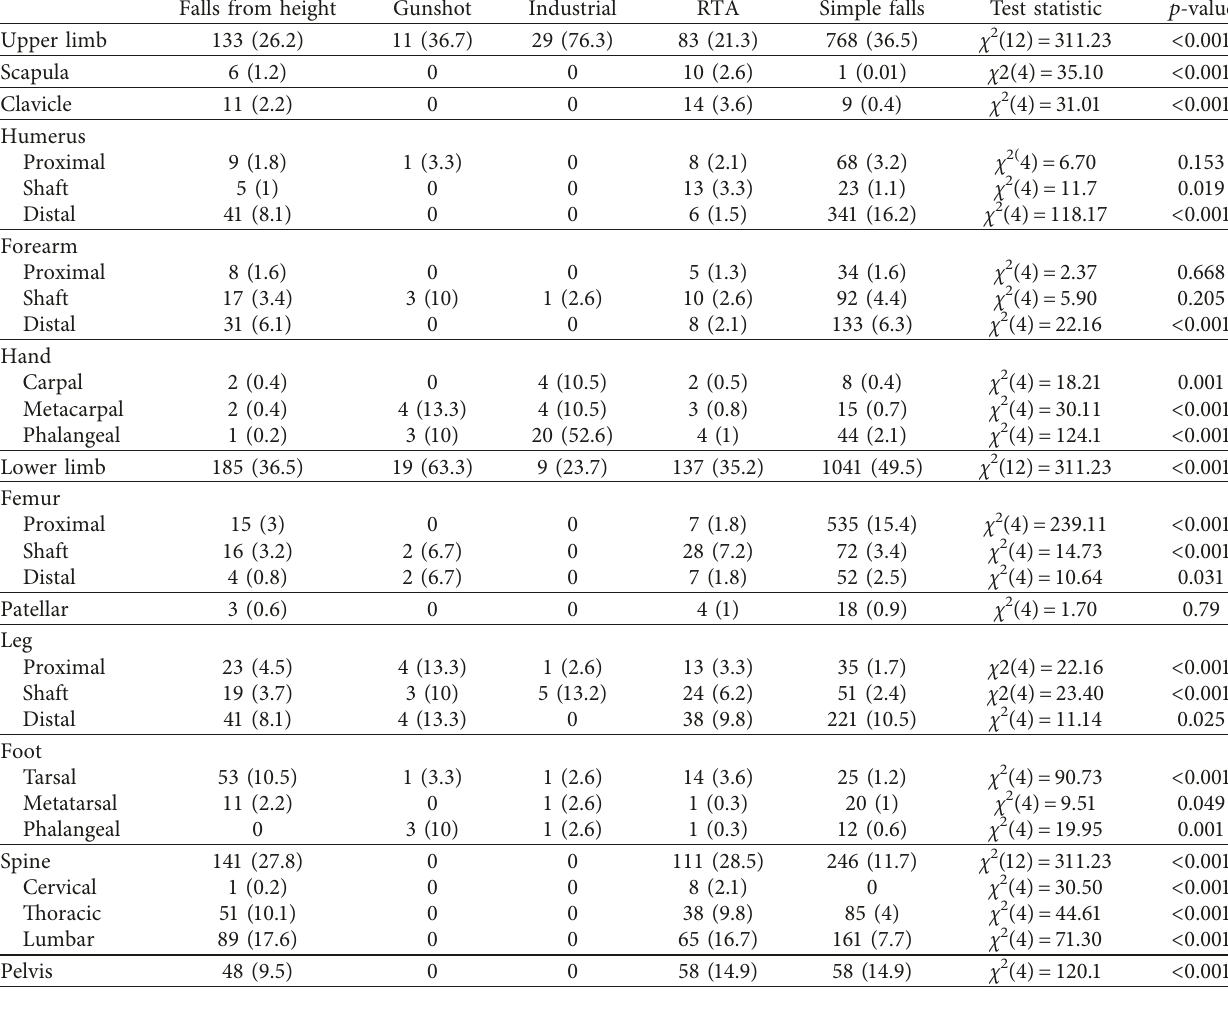
Table 5: Bivariate association between bone fractures with injury mechanism.